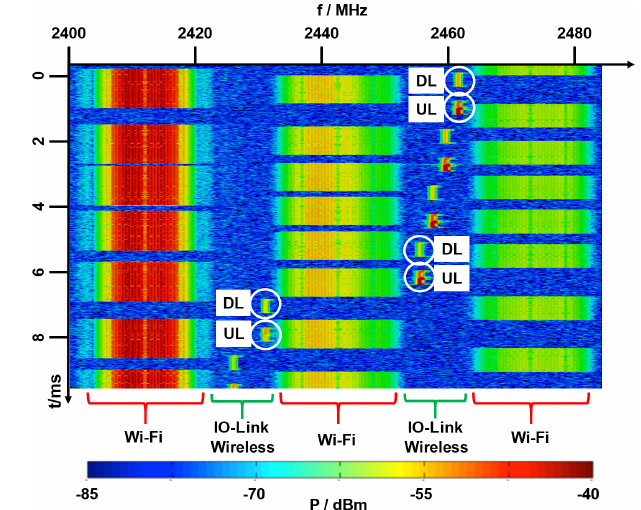
Figure 8. Spectrogram of the RF traffic in the 2.45GHz band. The IO-Link Wireless network comprises one master and two de- vices. RF communication is carried out between the occupied Wi- Fi bands. The downlink (DL) signal is followed by the uplink (UL) signals. In the spectrogram they can be distinguished by their dif- ferent signal powers.